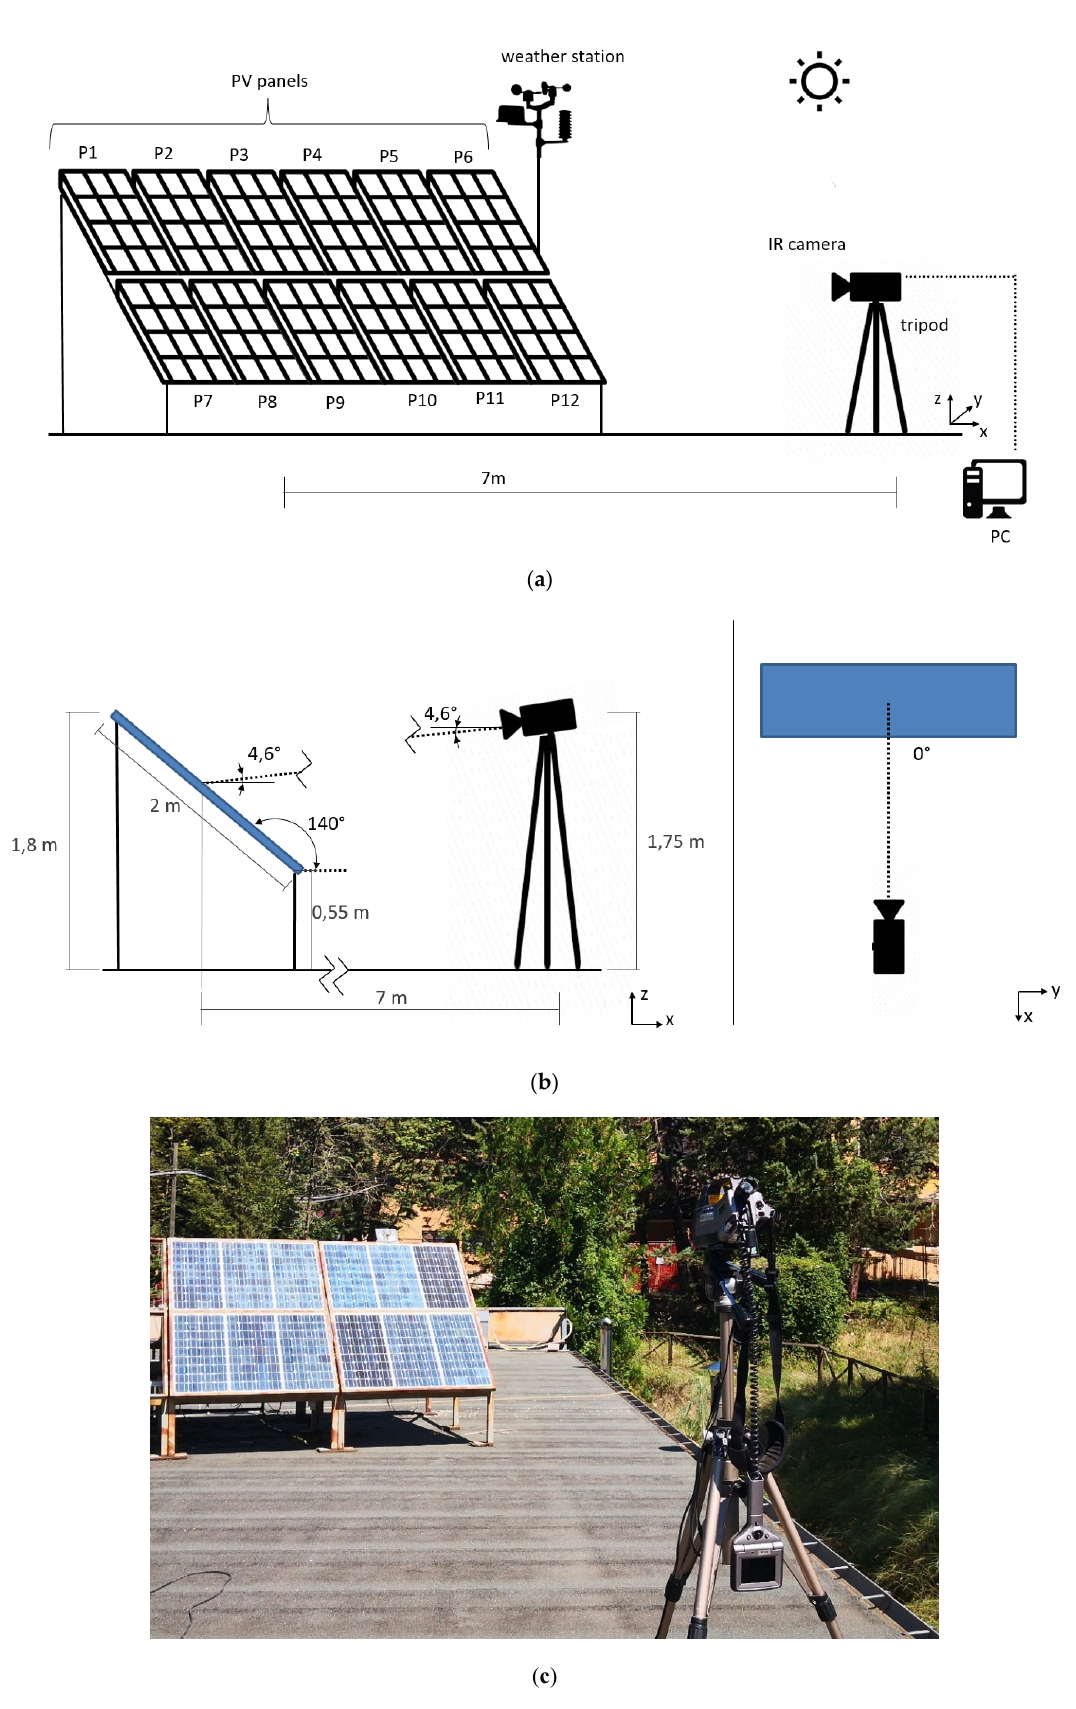
Figure 6. ( a ) Schematic of the experimental setup for thermal imaging; ( b ) thermal camera layout with respect to the panels (drawing is not to scale); ( c ) photograph of the setup.